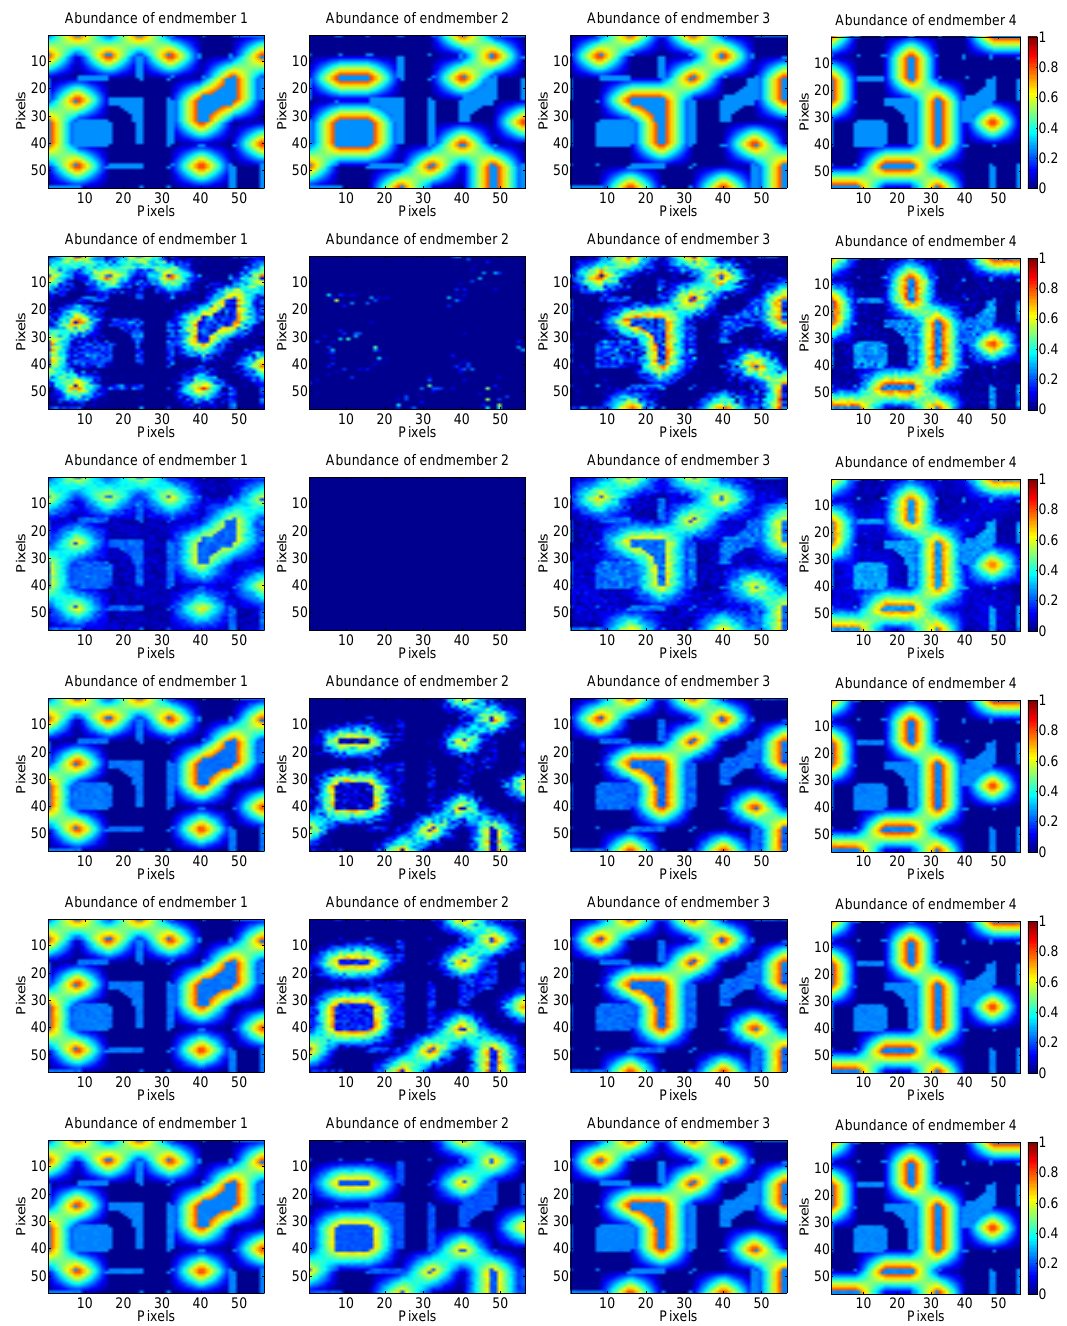
Figure 15. Abundance maps of four endmembers estimated with different methods under correlated noise with only mixed regions having 64 × 64 pixels and 224 bands. From top to bottom: ground truth, SUnSAL ( λ = 10 − 1 ), CLSUnSAL ( λ = 10), CUSAL-SP ( λ = ˆ s × 10 − 3 ), SU-NLE ( d = 1) ( λ = 10 − 2 ) and SU-NLE ( d = 2) ( λ =